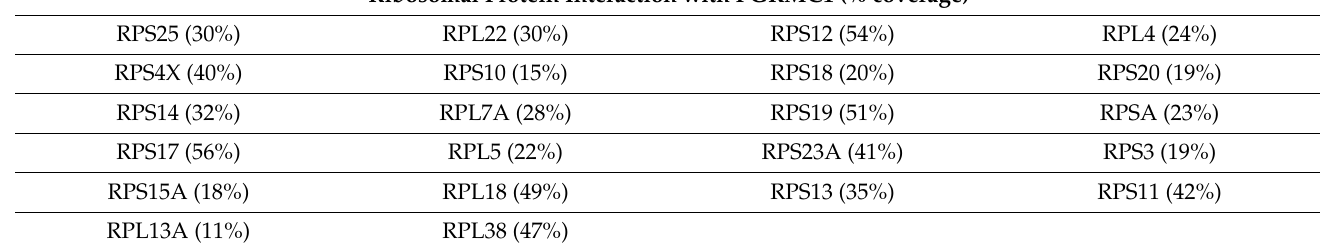
Table 3. Identification of 40s small ribosomal proteins (RPS) and 60s large ribosomal proteins (RPL) that interact with PGRMC1 in Ishikawa endometrial cancer cells. Flag antibody coated magnetic beads were used to pull-down PGRMC1-FLAG:protein complexes in PGRMC1-FLAG expressing cells. The list of proteins is based on matched peptides identified using Proteome Discoverer software with each protein having at least 10% protein coverage and two or more unique peptides assigned to each